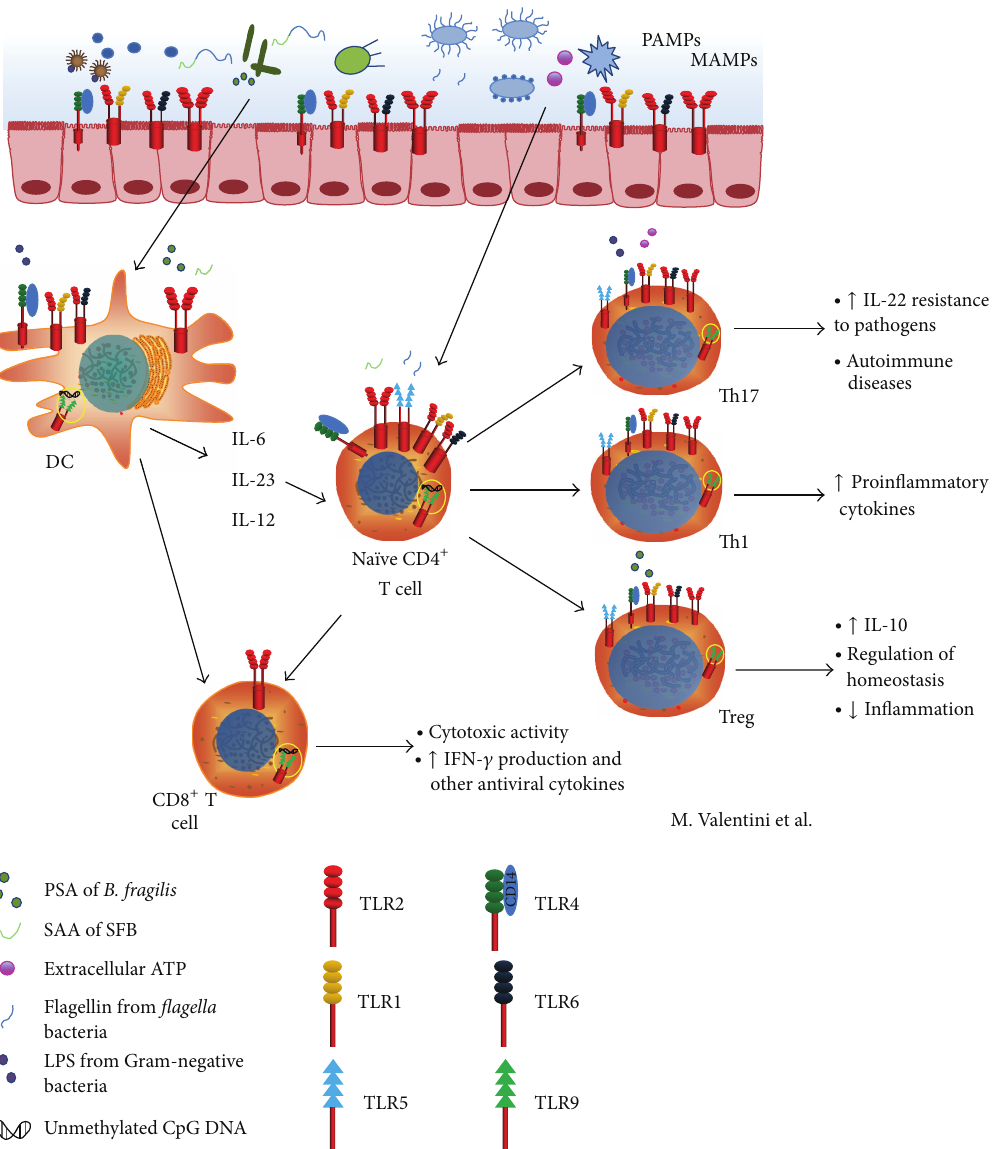
Figure 1: The mammalian gut microbiota is involved in the intestinal homeostasis and shapes the adaptive immune system. The interaction between TLRs and different ligands (such as polysaccharide A of B. fragilis , serum amyloid A protein of segmented filamentous bacteria, extracellular ATP from intestinal microbiota, flagellin, LPS, and unmethylated CpG of bacterial DNA) induces CD8 + T activation and na¨ıve CD4 + T polarization towards Th17, Th1, and Treg subsets. The Th17 cells act against pathogens and promote autoimmune disease. The Th1 cells upregulate the production of proinflammatory cytokines, whereas Treg cells produce IL-10 and are involved in the maintenance of homeostasis and in a downregulation of inflammation. Moreover, CD8 + T cells induce the IFN- 𝛾 and other cytotoxic mediators production.